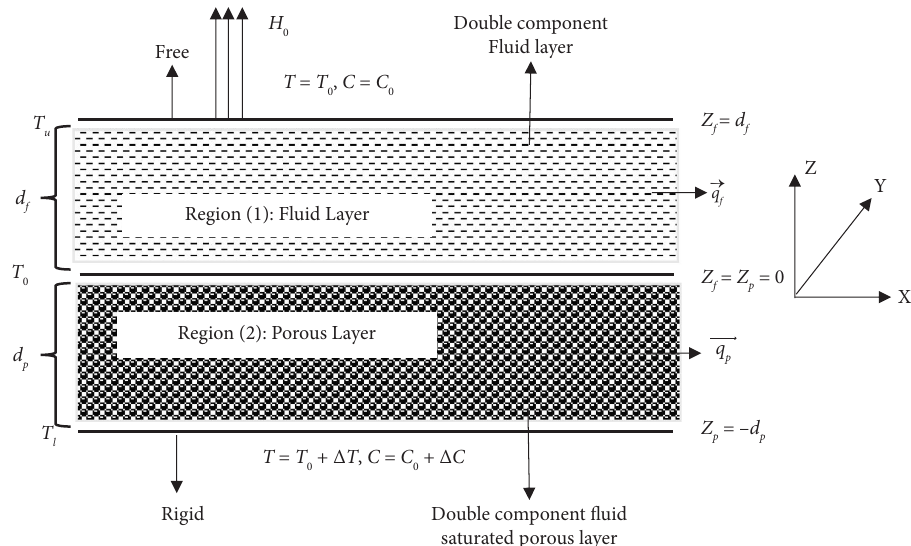
Figure 1: Physical model of the